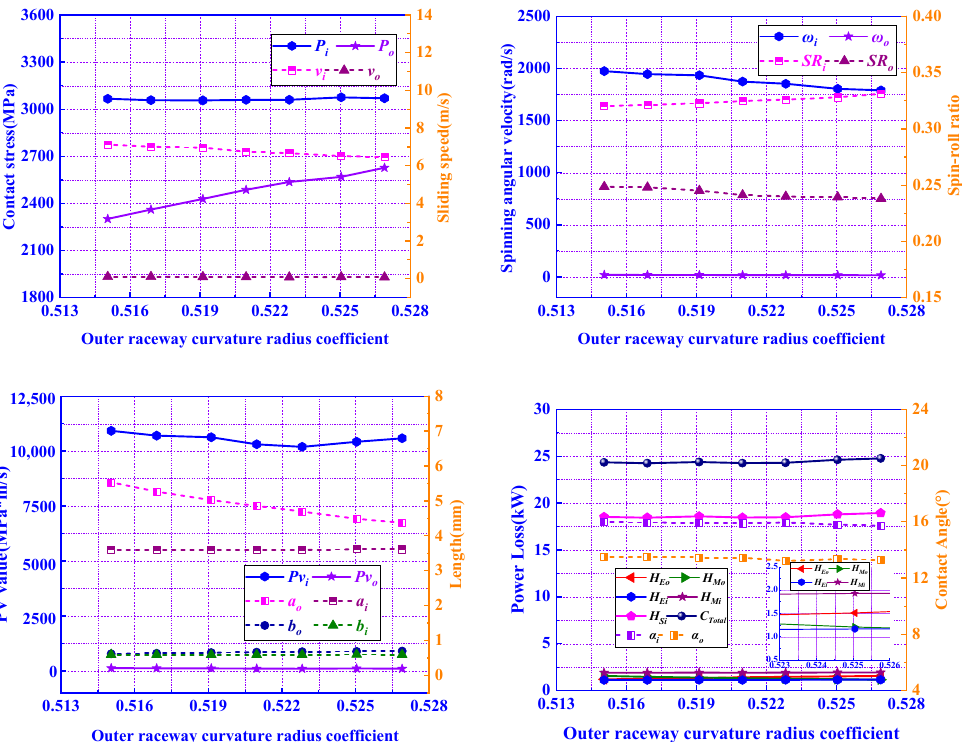
Figure 17. Influence of outer raceway curvature radius coefficient f o on power loss.